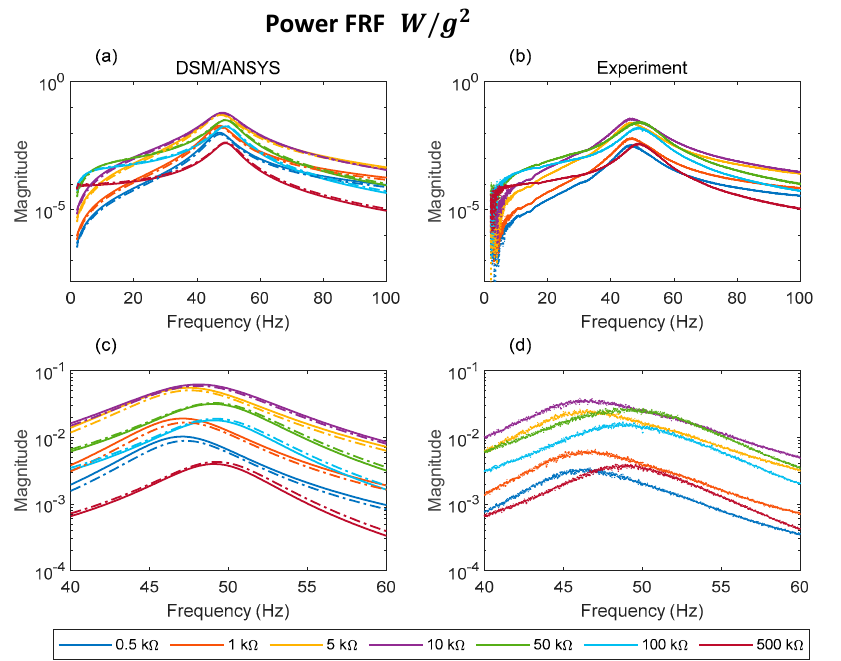
Figure 12. Analytical and experimental power FRFs for different loads: ( a ) DSM/ANSYS; ( b ) experiment; ( c ) DSM/ANSYS result zoomed in resonance region; ( d ) experimental result zoomed in resonance region (dashed and solid lines in ( a , c ) represent data associated with ANSYS plane element model and DSM, respectively).